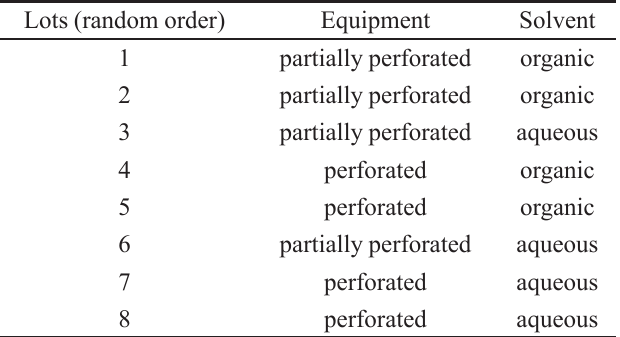
TABLE I - Factorial design of assays considering two variables: equipment and type of solvent Lots (random